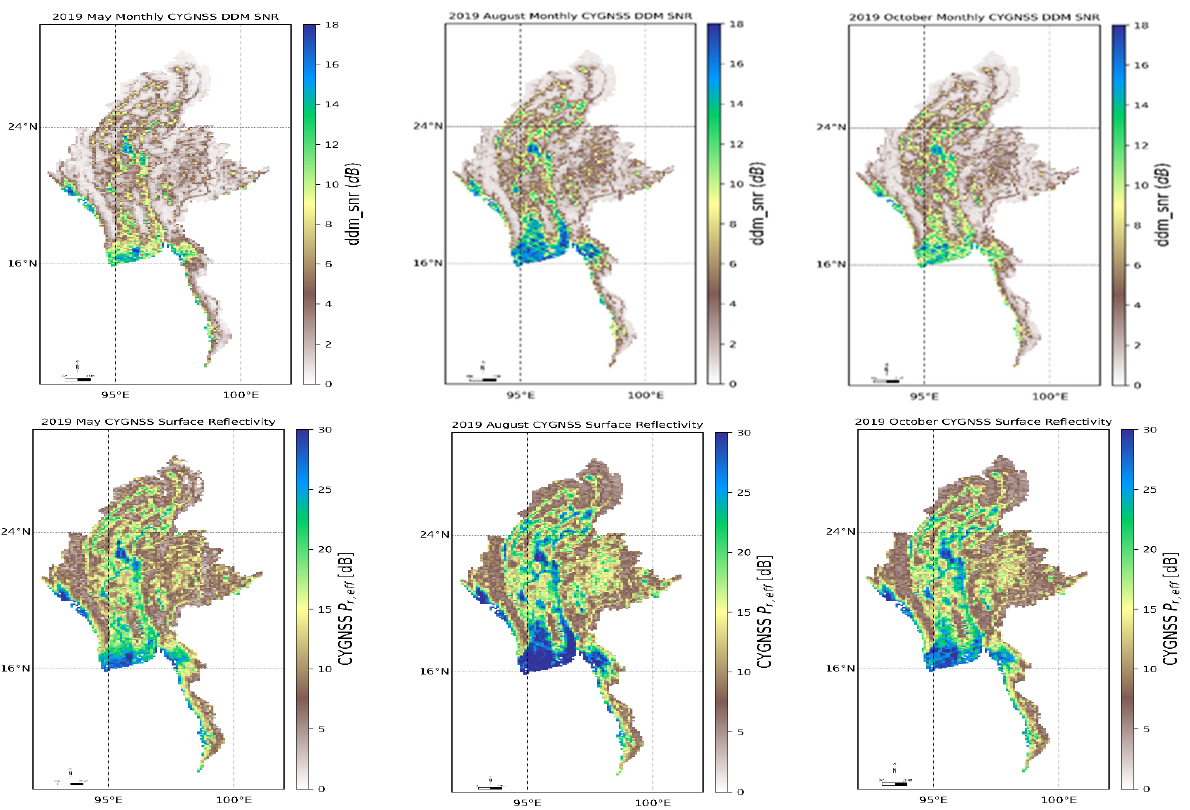
Figure 3. CYGNSS L1 DDM SNR and surface reflectivity of May, August, and October 2019.